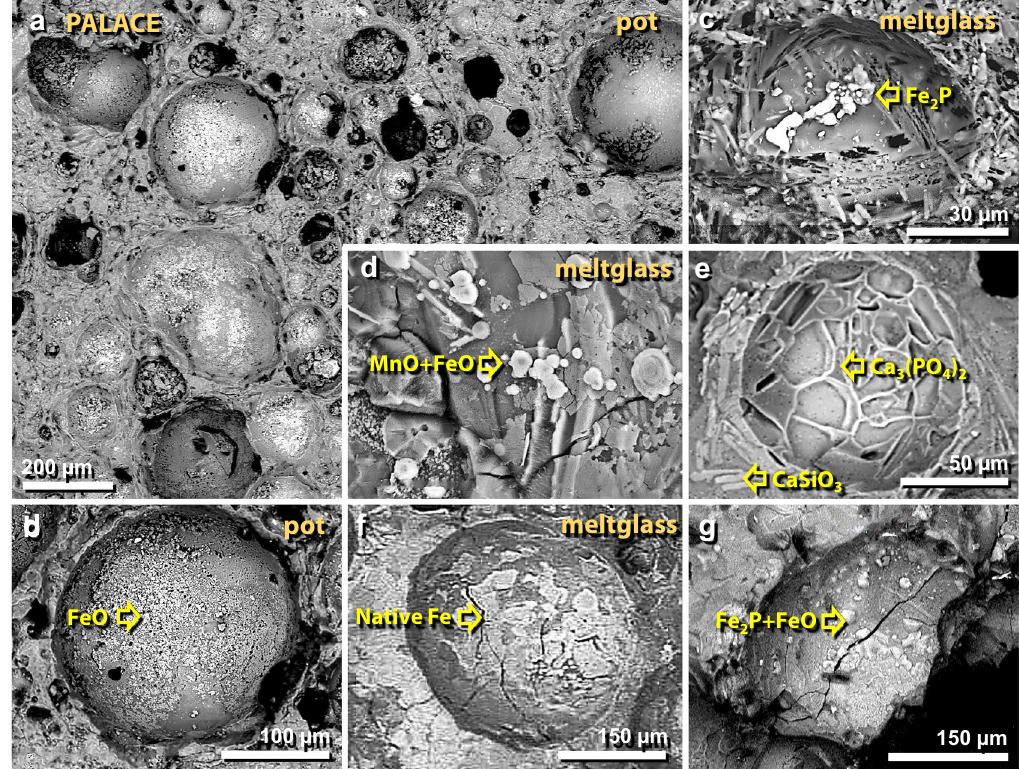
Figure 38. SEM images of gas vesicles in melted material from the palace. ( a ), ( b ) Vesicles in melted pottery are lined with crystals of iron and iron oxide (elemental Fe, Fe 2 O 3 , and/or Fe 3 O 4 ). ( c )–( g ) Vesicles in melted mudbrick and roofing clay often are lined with a variety of crystals including elemental Fe, iron oxide, Fe phosphide (Fe